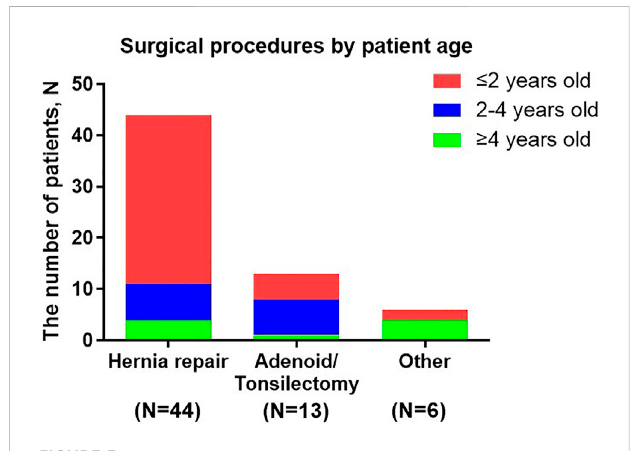
FIGURE 3 Surgical procedures by patient age. Other surgical procedures included: eye surgery, nasal polyp removal, intestinal surgery and scoliosis